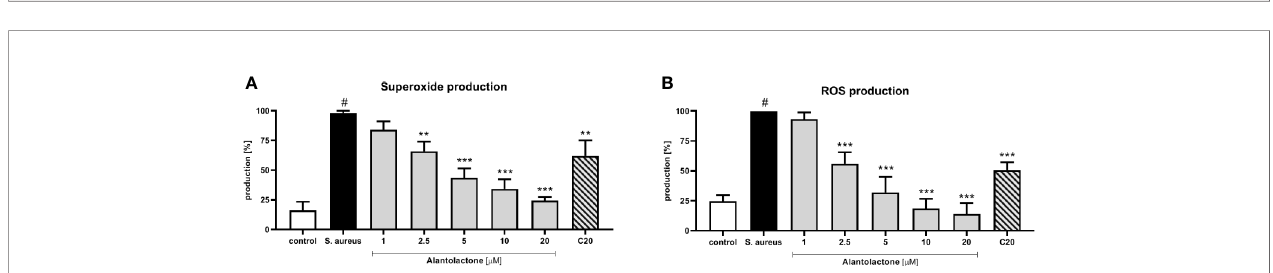
FIGURE 5 | The in fl uence of alantolactone on (A) phagosomal pH and (B) phago-lysosome fusion. Statistical signi fi cance: *p < 0.05, **p < 0.01, ***p < 0.001 versus stimulated control (ANOVA and Dunnett ’ s post hoc test); control — non-stimulated control; S. aureus — S.aureus -stimulated control. # statistically signi fi cant (p < 0.001) versus non-stimulated control.